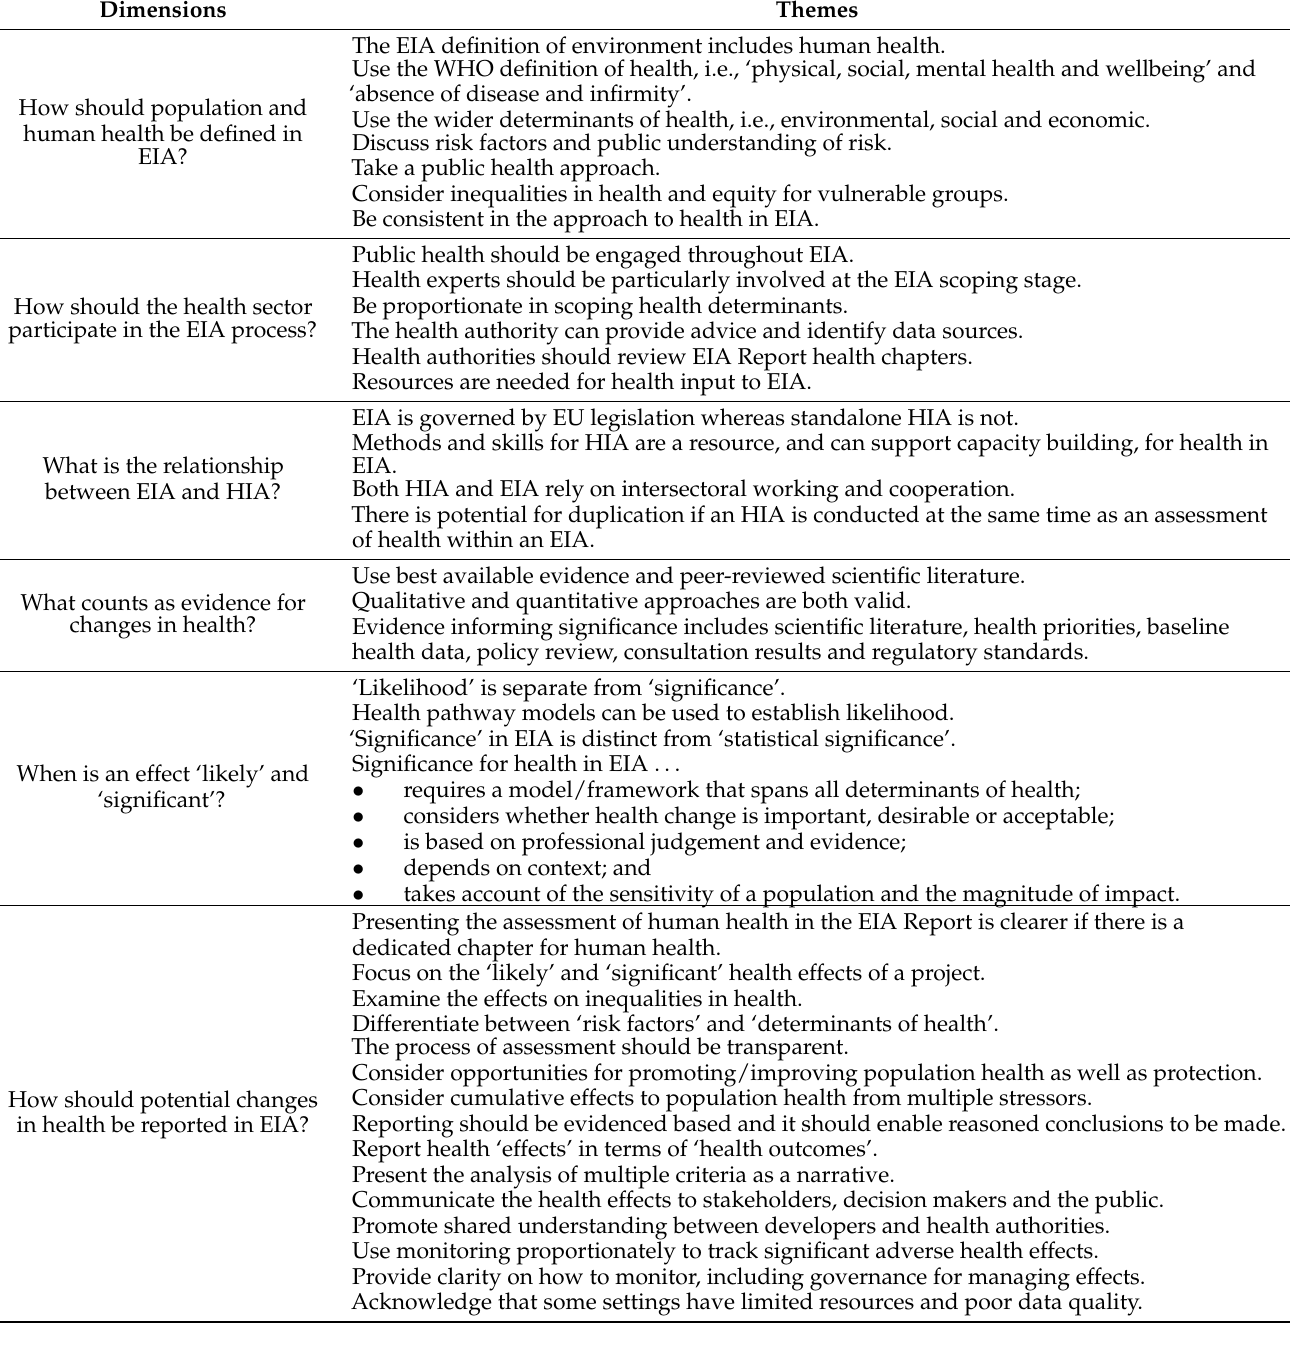
Table 1. Summary of themes from the